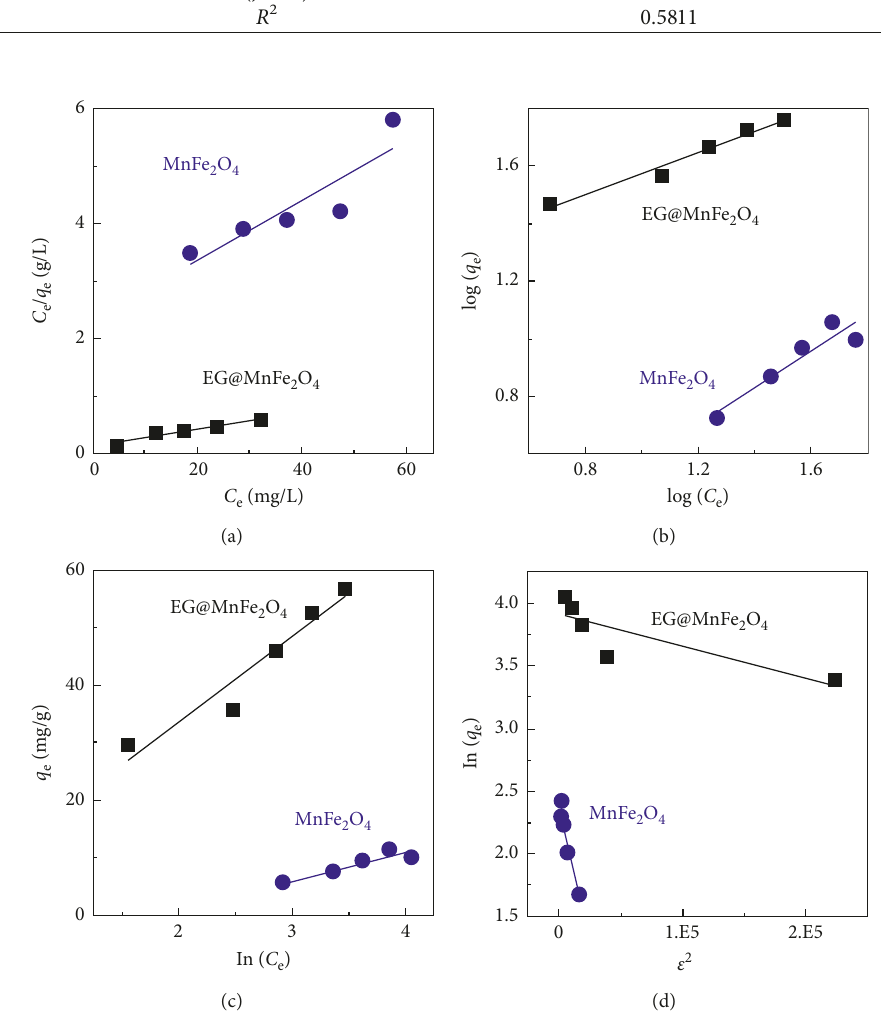
Figure 11: Linear plots of isotherm models: (a) Langmuir, (b) Freundlich, (c) Temkin, and (d) D-R for the adsorption of CR over EG@ MnFe 2 O 4 and MnFe 2 O 4